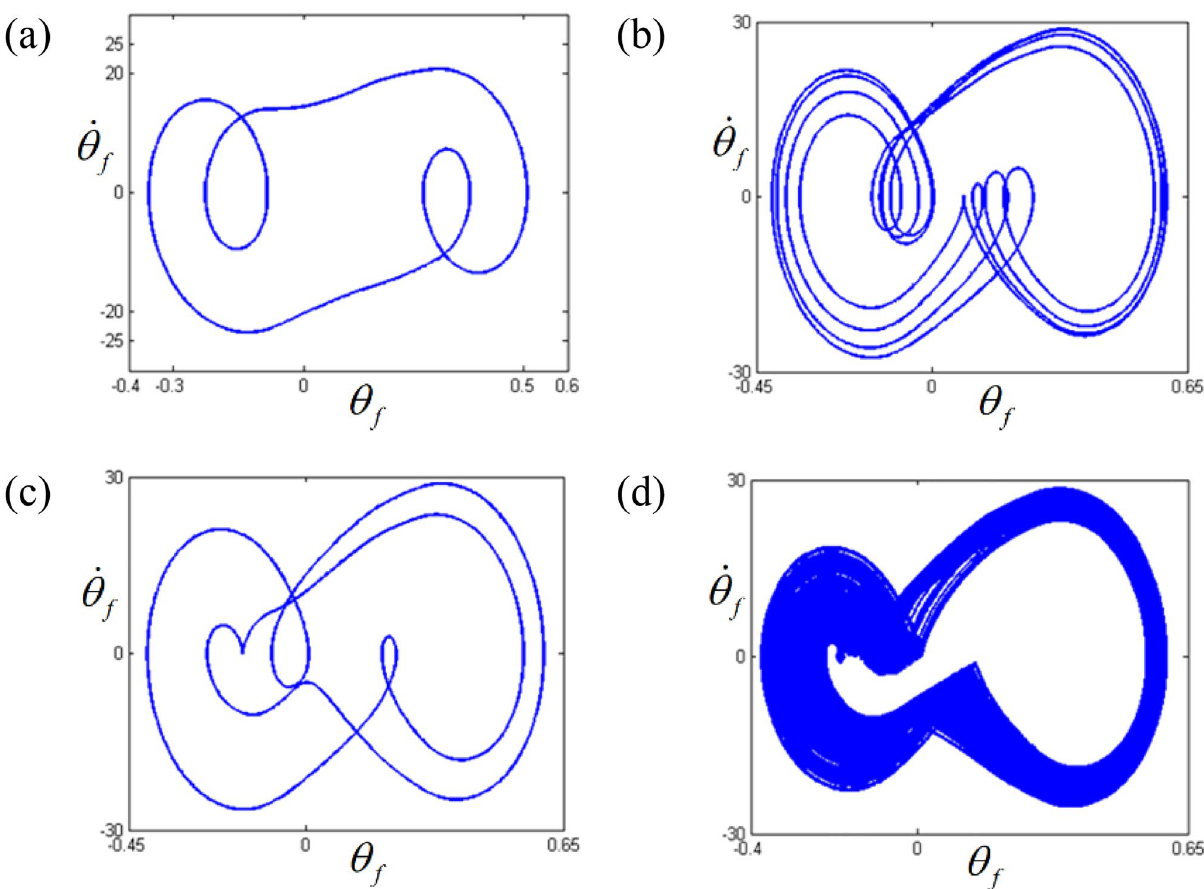
Figure 6. Comparisons of phase diagrams according to different frequency regimes: ( a ) phase diagram at ̟ = 0.26 ; ( b ) phase diagram at ̟ = 0.275 ; ( c ) phase diagram at ̟ = 0.285 ; ( d ) phase diagram at ̟ = 0.315